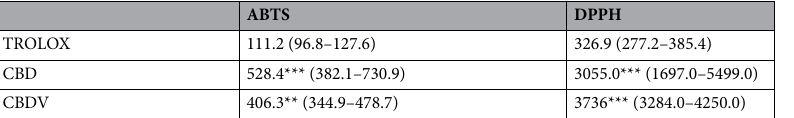
Table 2. EC50 values. EC50 values with confidence limits (95% probability, in brackets), expressed in µM, obtained by ABTS and DPPH assays testing Trolox, CBD and CBDV effectiveness. Dunnett’s multiple comparison test was performed with the cannabinoids and Trolox results: **p < 0.001 and ***p <